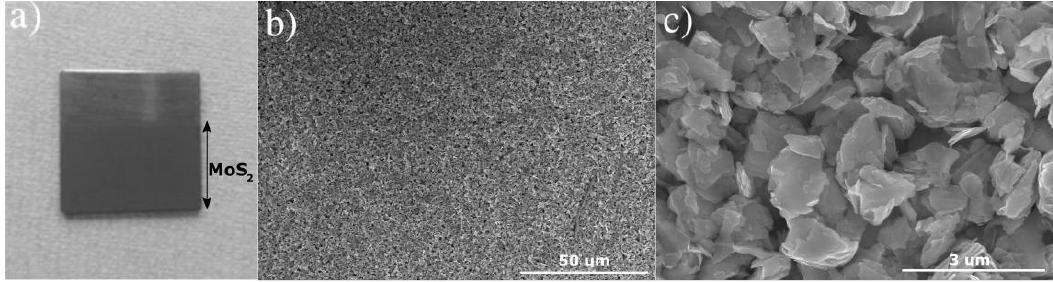
Figure 8. ( a ) Picture of the sample coated by EPD with MoS 2 particles, ( b , c ) SEM images of sample in ( a ).